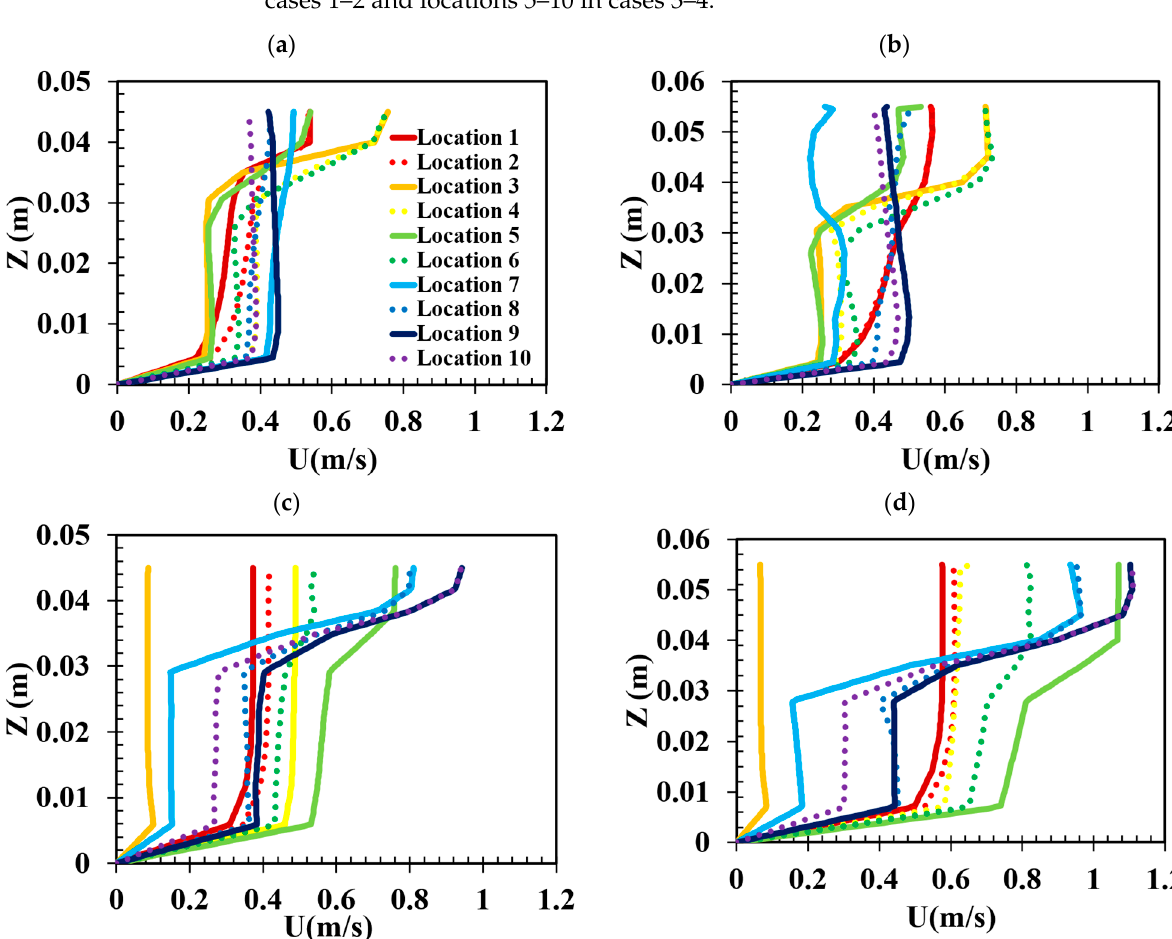
Figure 5. ( a – d ) The simulated results of mean streamwise velocity profiles ( u ) at specified locations: ( a ) case 1; ( b ) case 2; ( c ) case 3; ( d ) case 4. ( a ) case 1; ( b ) case 2; ( c ) case 3; ( d ) case